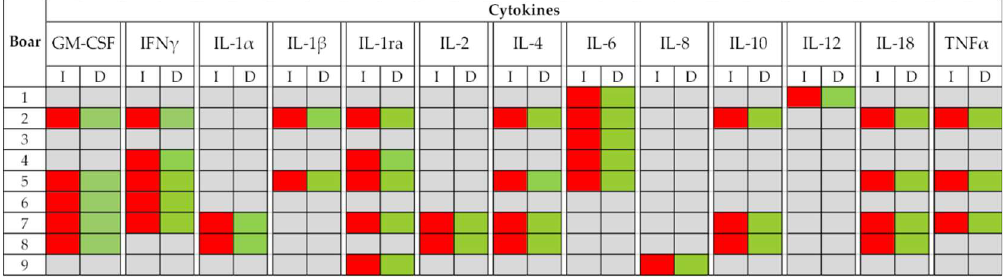
Figure 3. Variation pattern of cytokine concentrations in seminal plasma from ejaculates collected from nine boars (20 ejaculates per boar) during the times of year when increasing (I, January to June) or decreasing daylight/temperature (D, July to December) dominated. Grey box indicates no differences between periods, while red and green boxes indicate a relationship between dominating seasonal parameters with high and low cytokine concentrations ( p < 0.05), respectively. Cytokines: Granulocyte macrophage colony-stimulating factor (GM-CSF), interferon-gamma (IFNγ), interleukin (IL)-1 α , IL-1 β , IL-1ra, IL-2, IL-4, IL-6, IL-8, IL-10, IL-12, IL-18, and tumor necrosis factor- α (TNF α ).